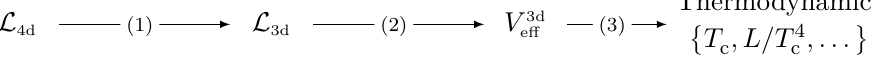
Figure 1 . Schematic illustration of a perturbative 3d EFT computation of thermodynamics. This article advocates a novel prescription for combining (1) → (2) → (3) (cf. section 2). This specific implementation aligns with the generic steps ( d ) → ( e ) → ( f ) in figure 2 in